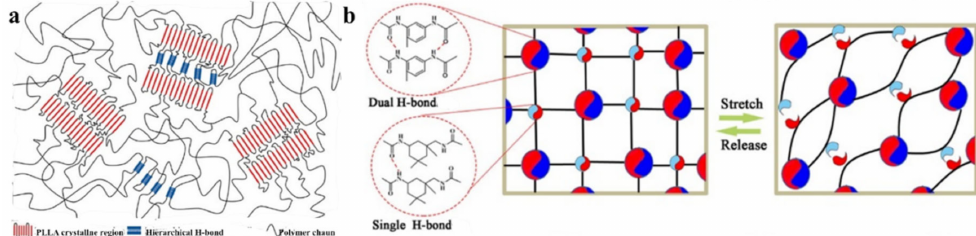
Figure 10. ( a ) Schematic representation of SHPs based on poly( l -lactic acid) (PLLA) crystalline segments and hierarchical H-bond. Reprinted with permission from [128]. Copyright (2020) American Chemical Society. ( b ) Diagram image of the networks with H-bonds of di ff erent strength. Reproduced from [129] with permission from